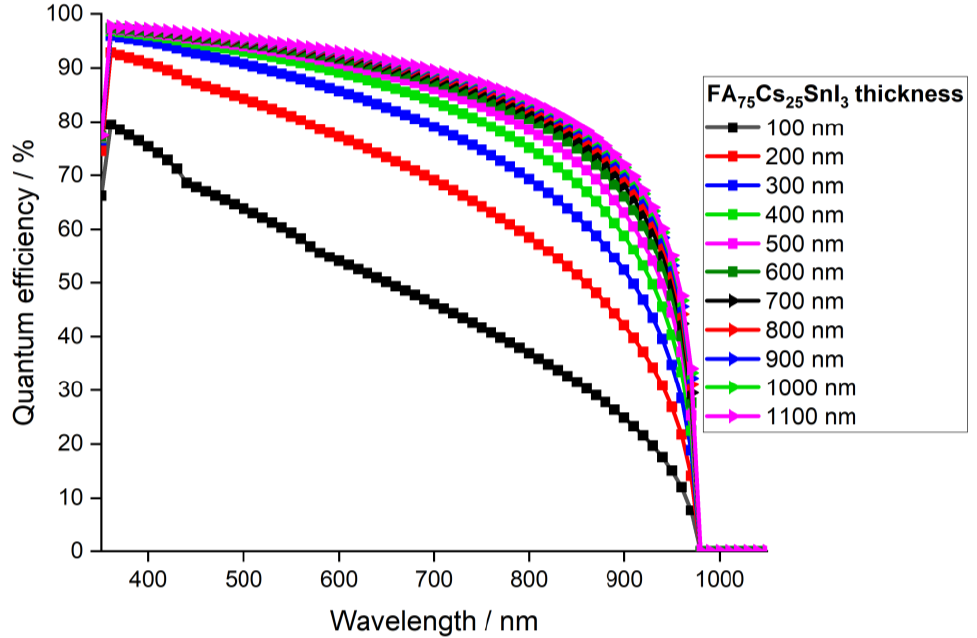
Figure 10. Quantum efficiency of the simulated device with absorber layer thickness.